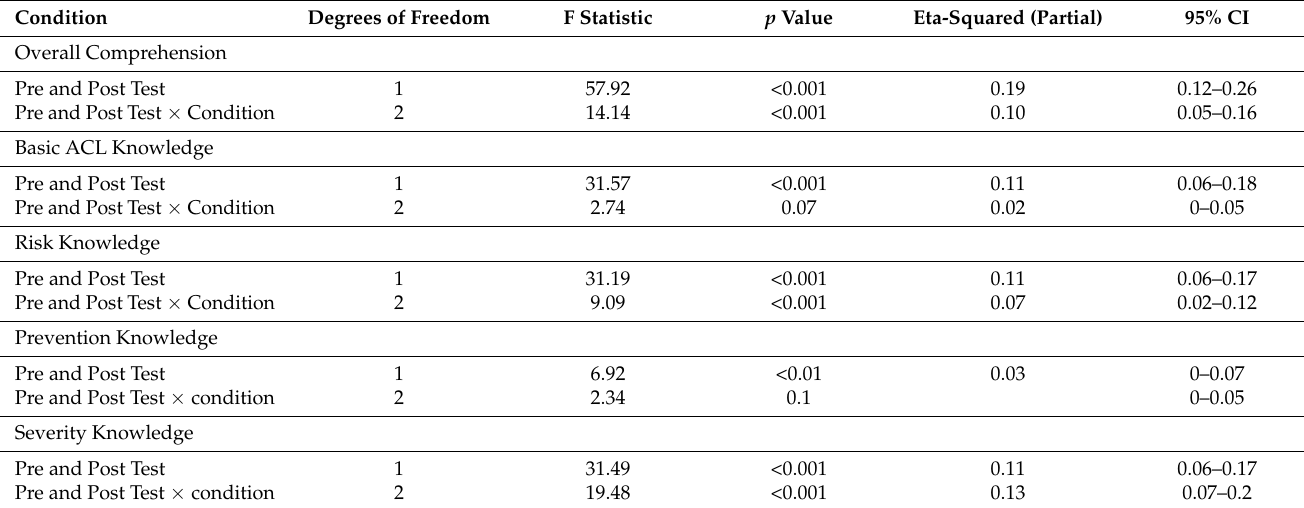
Table 2. Mixed ANOVA results across knowledge